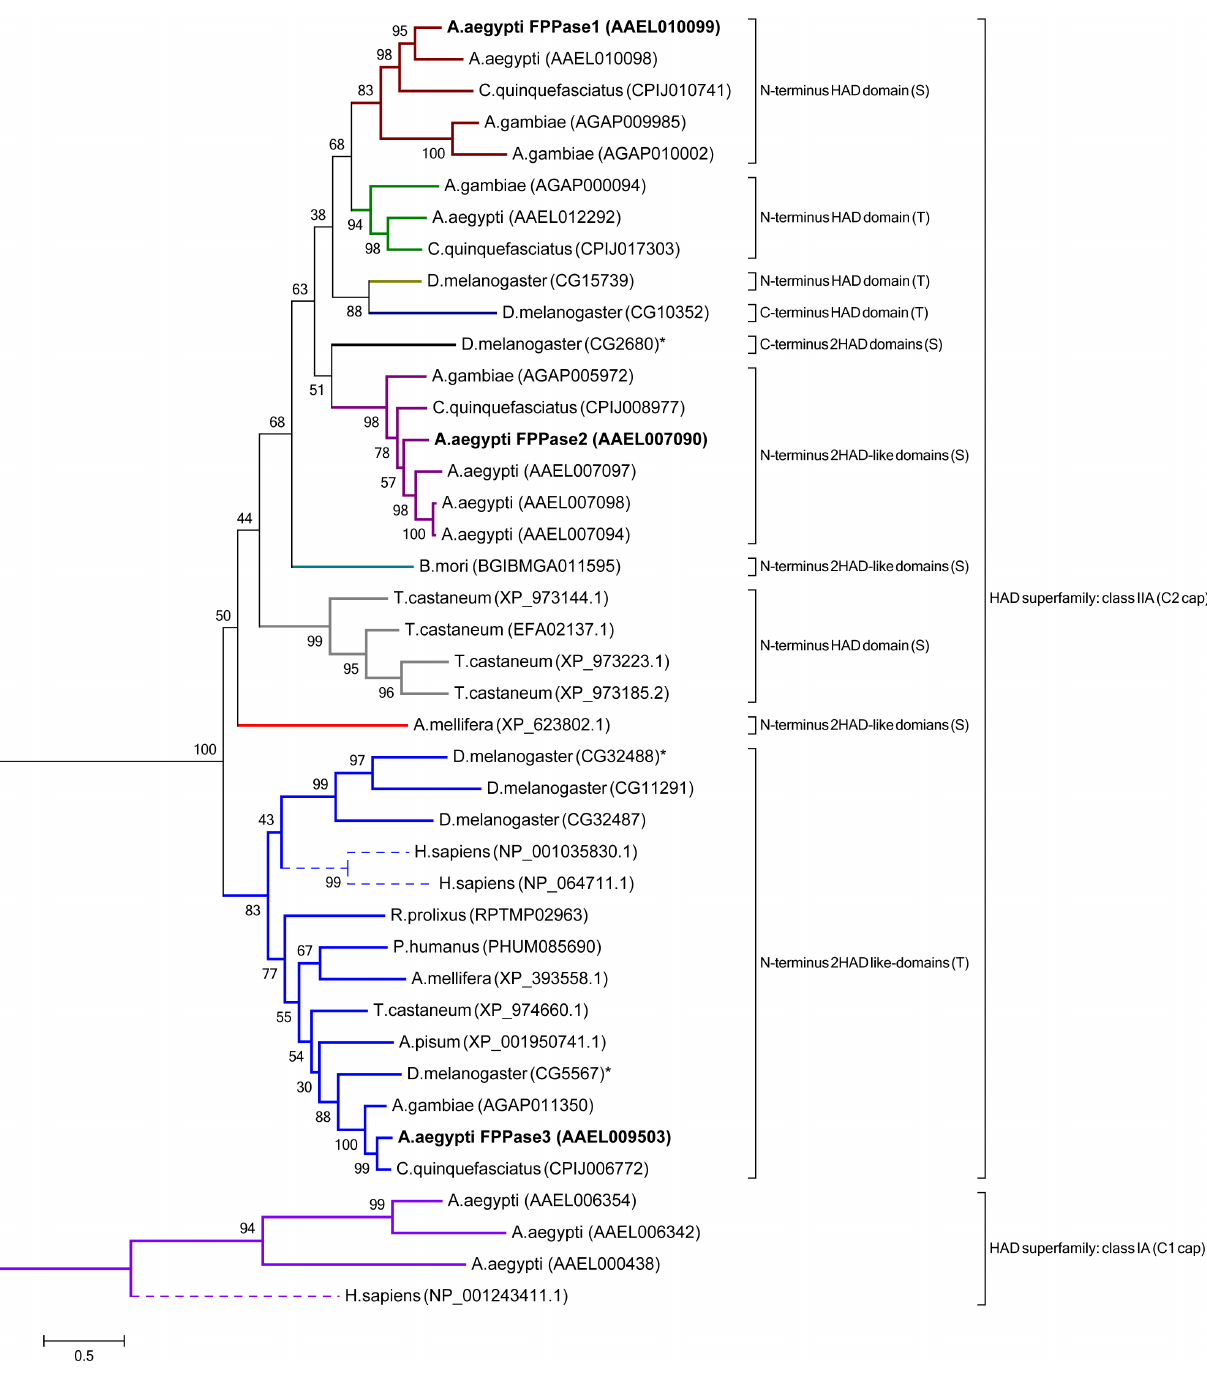
preparing it for nucleophilic attack by the first conserved aspartate on motif I [13] (Figure S4).